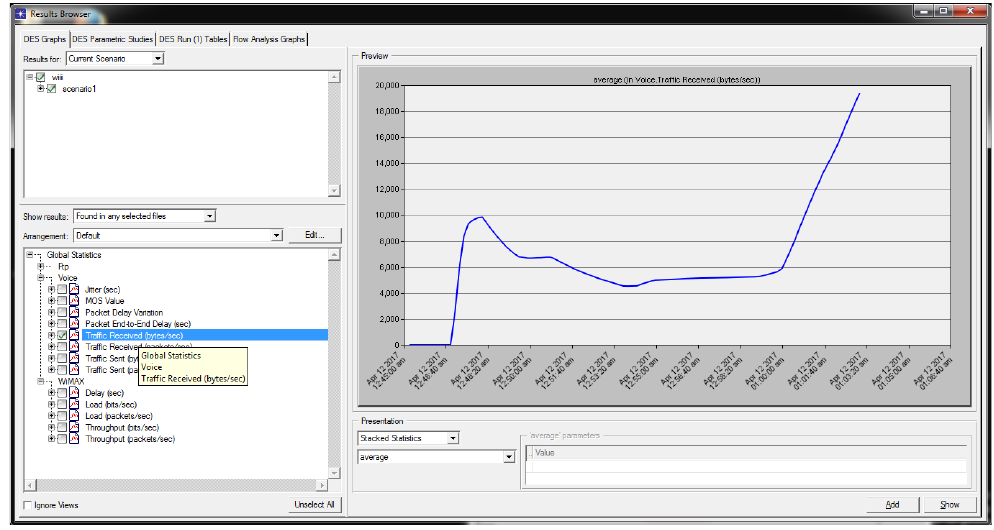
Fig. 10. Global Statistics WiMax VoIP Traffic received Byte/second for overall network, reaches 18000 byte per second for maximum. And it is a sufficient value for the